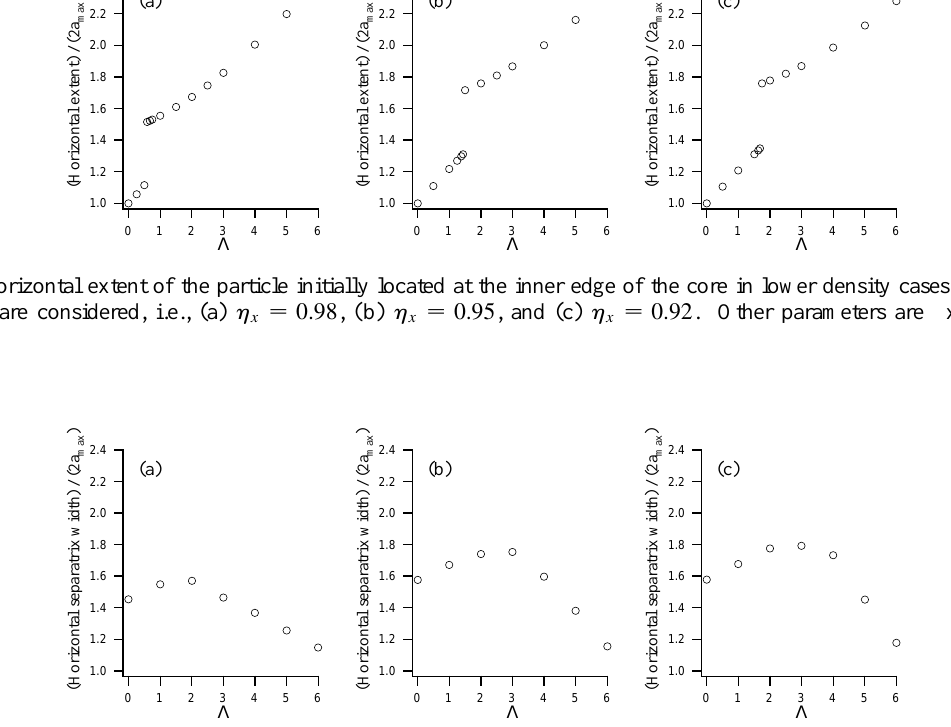
FIG. 8. The horizontal separatrix width of the 2:1 particle-core resonance in lower density cases. Three different beam densities are considered, i.e., (a) h x (cid:1) 0.98 , (b) h x (cid:1) 0.95 , and (c) h x (cid:1) 0.92 . Other parameters are fixed to M (cid:1) 0.13 and j (cid:1) 0.15